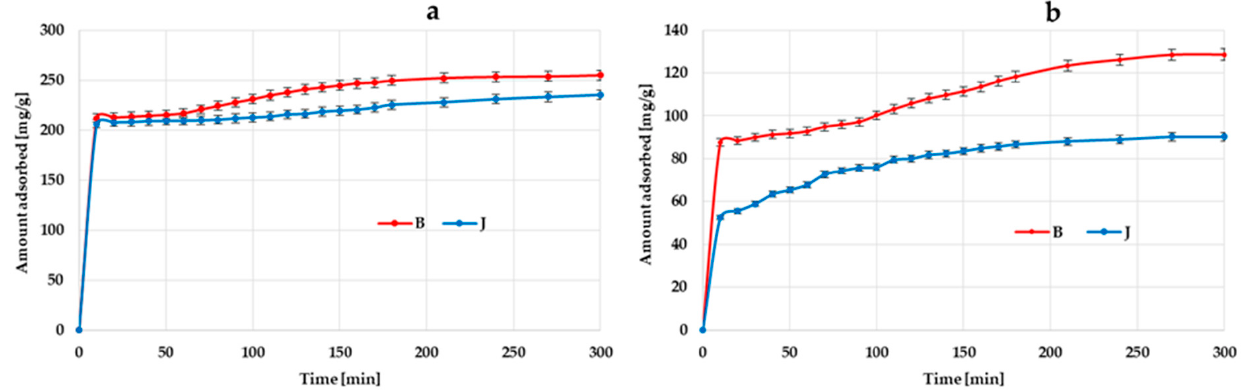
Figure 10. Effect of phase contact time on methylene blue ( a ) and malachite green ( b ) adsorption on the carbonaceous materials derived from the used carbon filters.